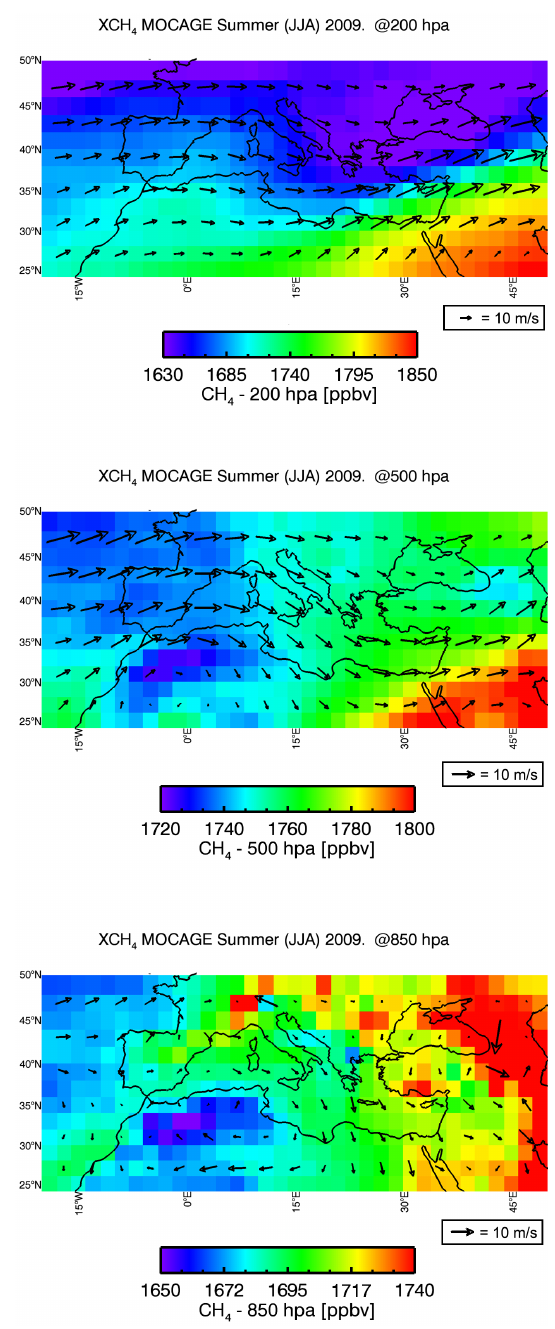
Figure 1. From bottom to top: fields of CH 4 as calculated by MOCAGE and averaged for summer (JJA) 2009 at 850, 500 and 200hPa. Superimposed are the horizontal winds from ARPEGE av- eraged over the same period. In order to highlight the CH 4 hori- zontal gradients, the range of the colour scale changes from top to